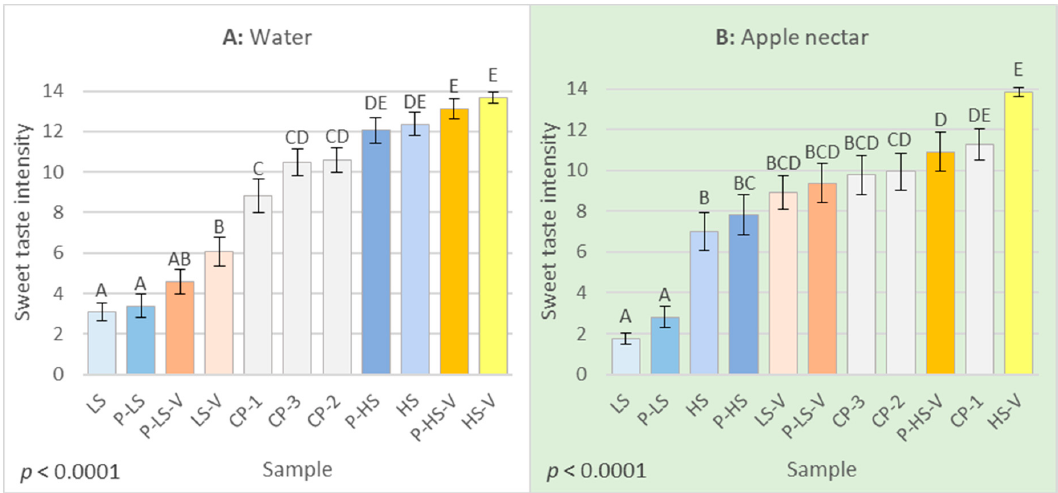
Figure 3. Means of sweet taste intensity ± std. error of the mean for each sample in the Descriptive Analysis (DA) of the aqueous matrix ( A ) and the apple nectar matrix ( B ). Different letters indicate significant ( p ≤ 0.05) differences between samples in each matrix. Samples are labelled according to